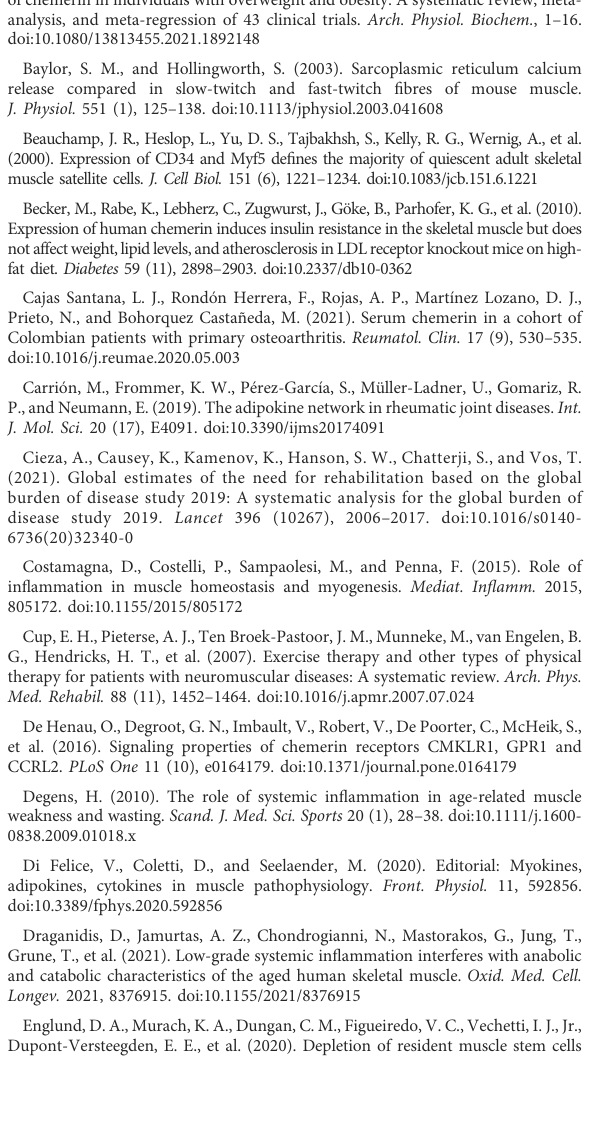
SUPPLEMENTARY FIGURE S2 Acute pharmacological inhibition of CMKLR1 has limited effects on markers of myogenesis, calcium handling and in fl ammation. Relative mRNA levels of genes involved in myogenesis, calcium regulation and